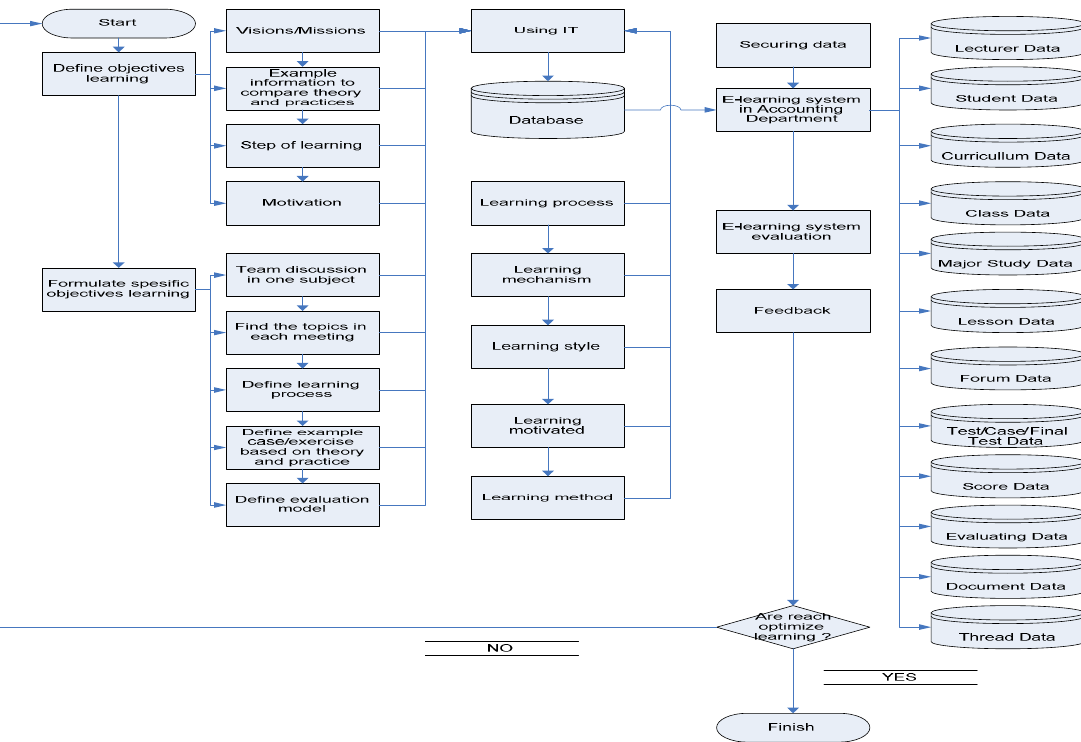
Figure 3. E-learning Model Accounting Department Airlangga